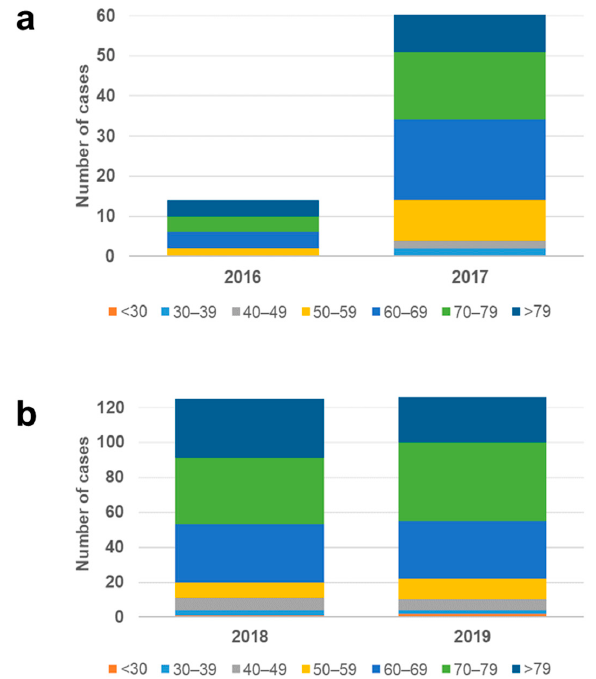
Figure 5. Age distribution of analyzed strains belonging to ST117, carrying vanB collected in ( a